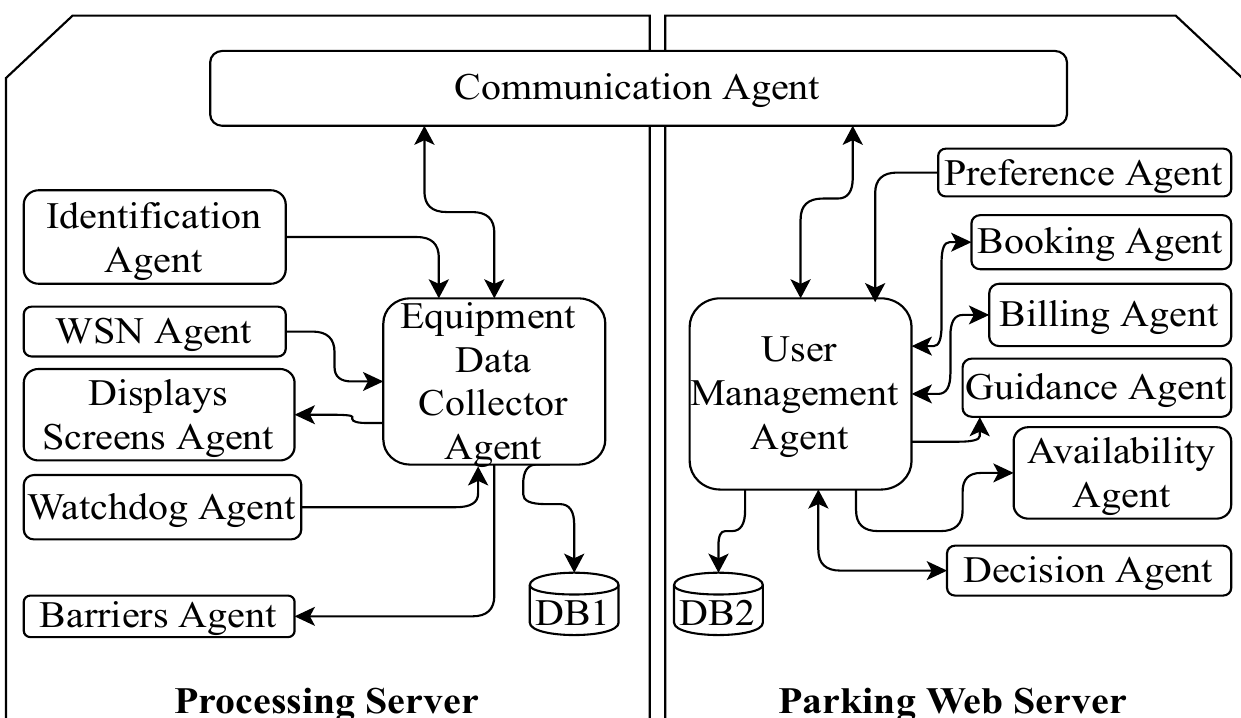
Figure 6. Parking equipment data gathering software